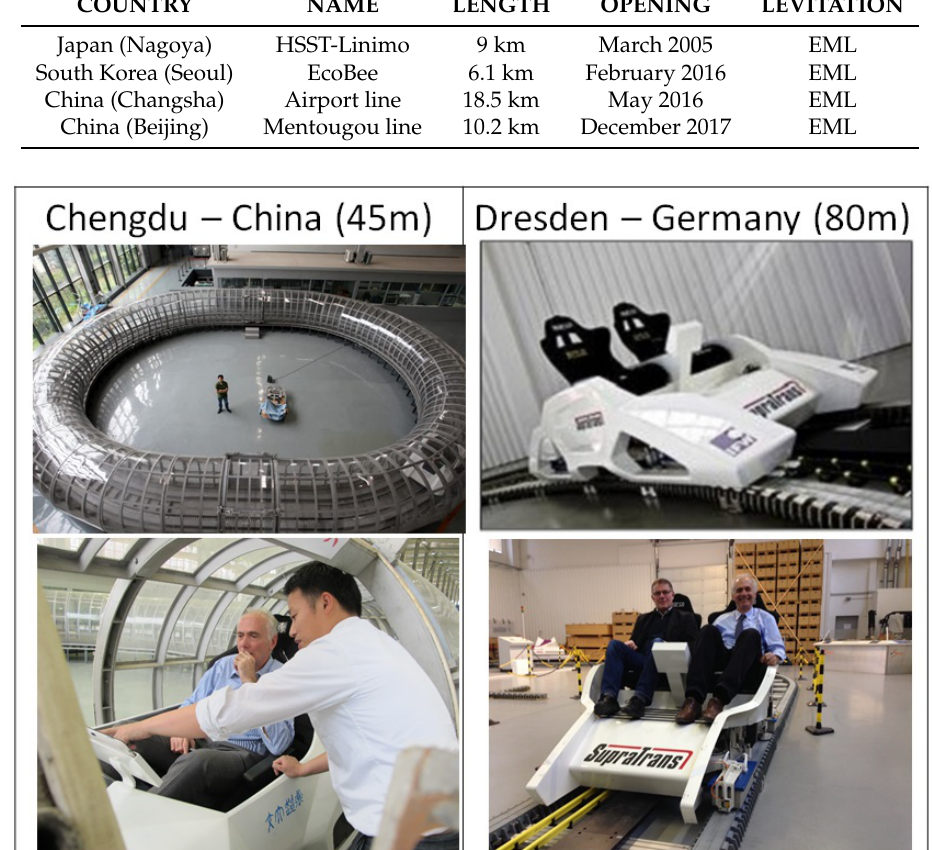
Figure 4. Superconducting Levitation (SML) projects developed in China ( left ) and Germany ( right